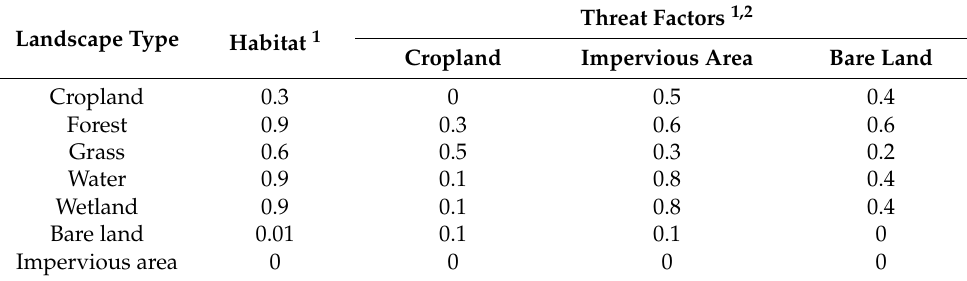
Table A1. Sensitivity of different landscape types to different threat